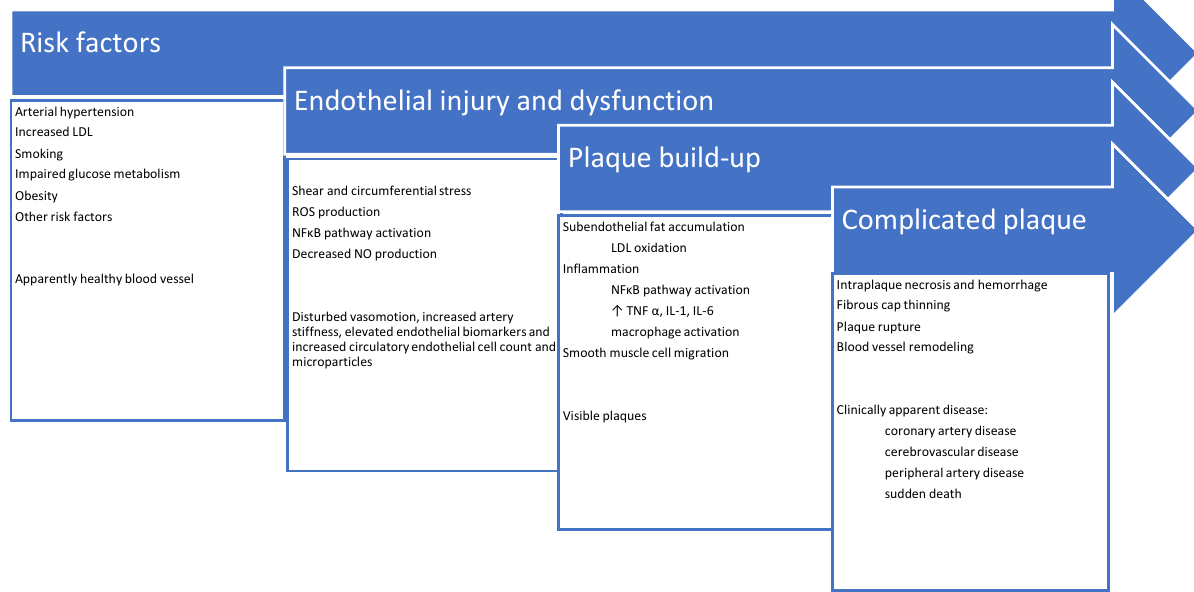
Figure 1. Schematic summary of atherosclerosis pathophysiology and its clinical